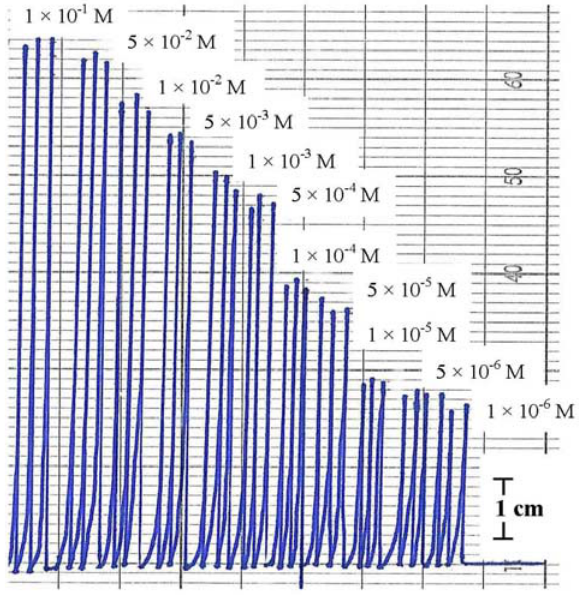
Figure 6. The FIA peak heights for the standard solutions of Hg(NO measurements.